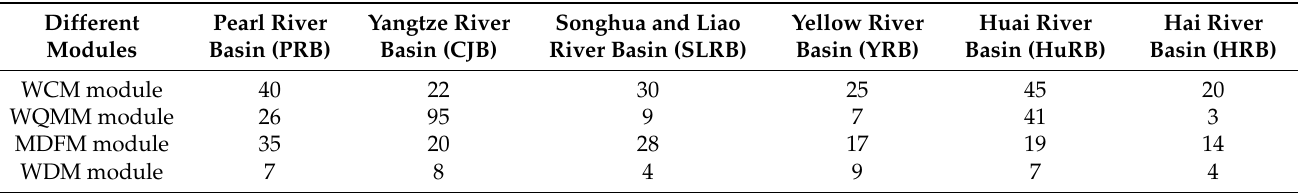
Table 3. Completion percentages for the four modules in the different basins (unit: %). WCM, total water consumption management; WQMM, water quality monitoring and management; MDFM, minimum discharge flow management; WDM, water dispatch management.